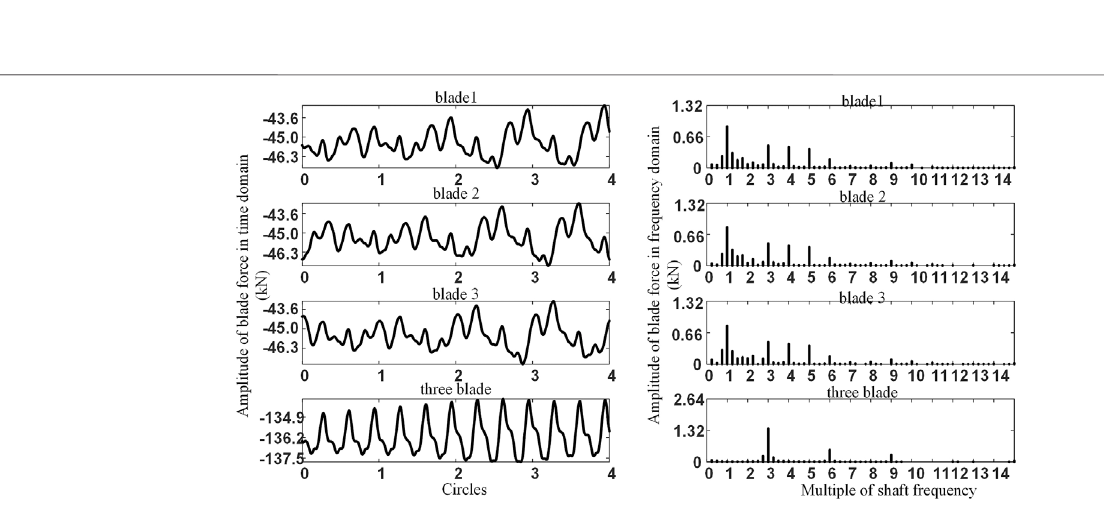
FIGURE 8 | Steady force of impeller and static displacement of rotor system.